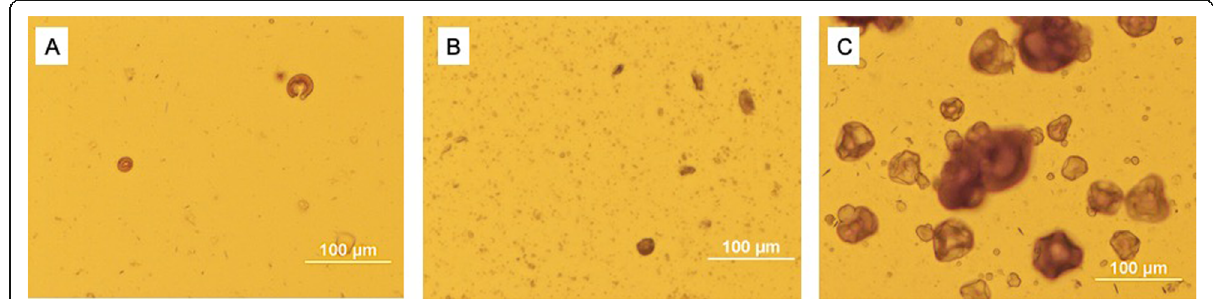
Fig. 6 Optical light microscope images at 200x magnification depicting the microstructures of diluted feed dispersions with a 1.25 protein:sucrose ratio and 1.5% PP formulated with WPI ( A ), SPI ( B ), and PPI ( C )